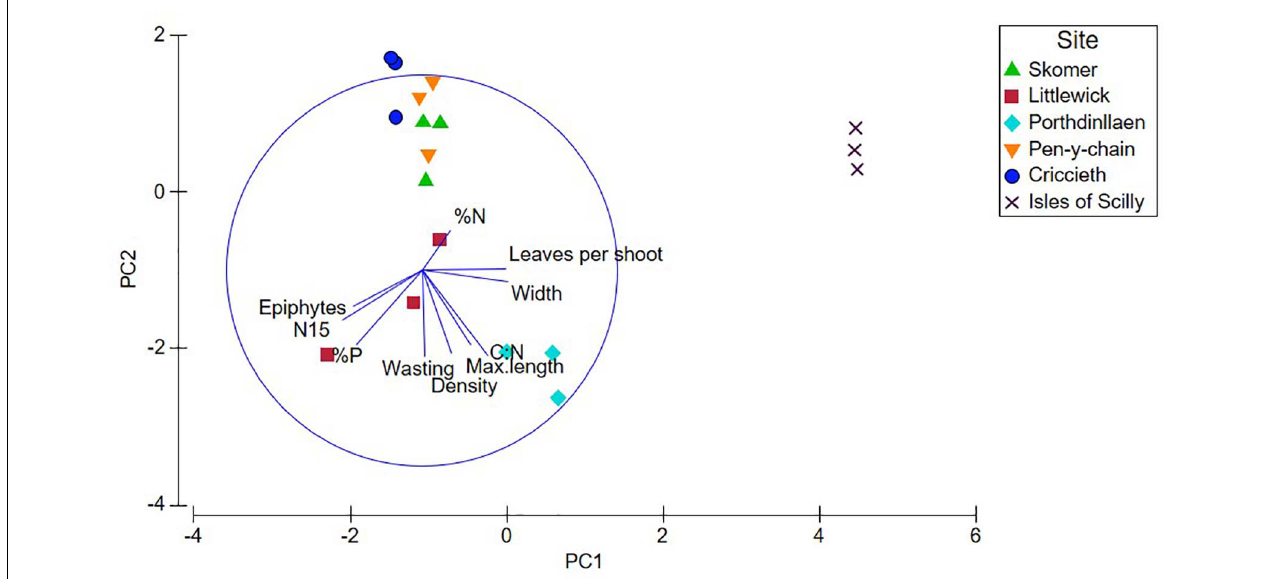
FIGURE 3 | Principal Components Analysis (PCA) plots for shoot, nutrient, and stable isotope data for each site, plotted with shoot density and metrics (max. leaf length, width, and leaves per shoot). Nutrient data for Isles of Scilly provided from Jones et al. (2018).